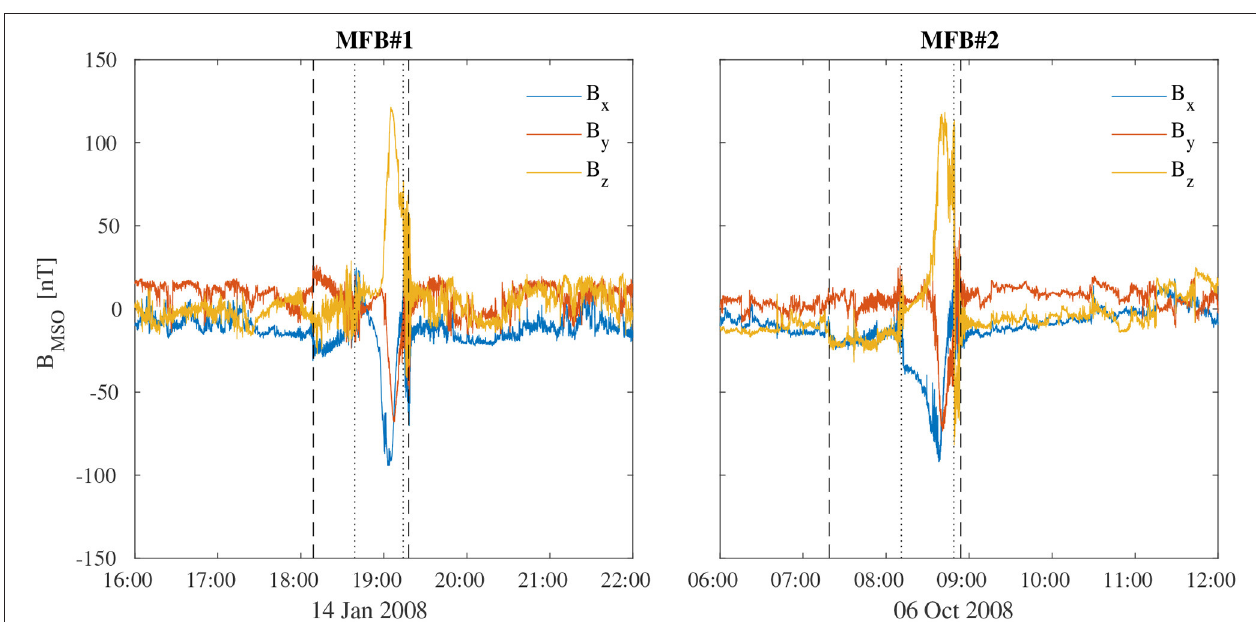
FIGURE 2 | Magnetic field components in the MSO reference frame measured during the first (left) and the second (right) Mercury flyby. The vertical dashed and dotted lines refer to the bow shock and magnetopause crossings, respectively.